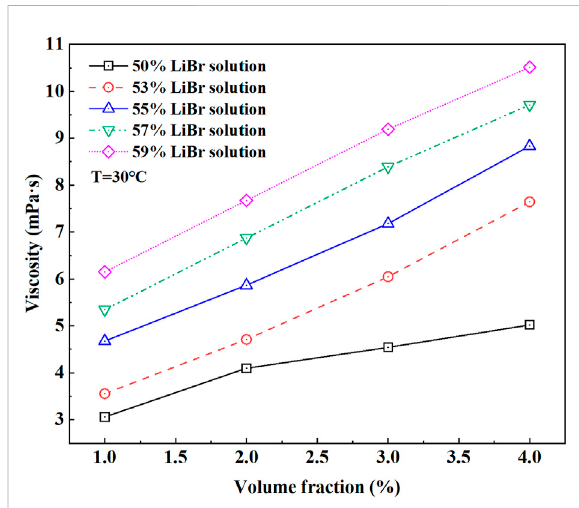
FIGURE 7 The variation of the viscosity of different concentration LiBr with the E414 volume fraction.